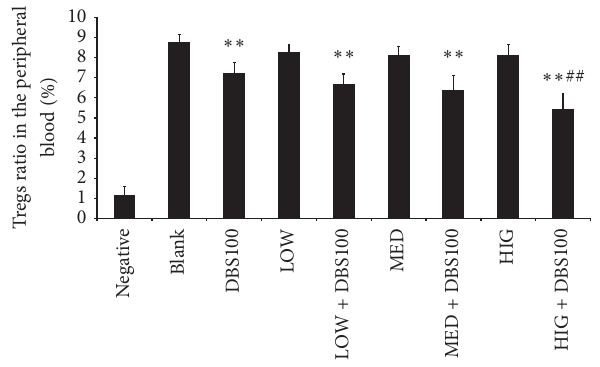
Figure 9: Ratio of CD4+CD25+CD127dim/CD4+ (Tregs) in mice. ∗∗ 𝑃 < 0.01 , compared with the blank group. ## 𝑃 < 0.01 , compared with the Citrobacter freundii DBS100 treated alone